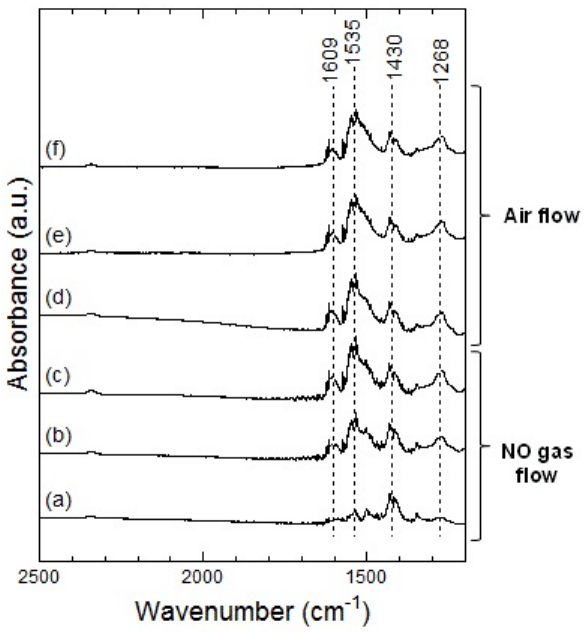
Figure 13. DRIFT spectra of Co 1 ppm of NO in air for ( a ) 2 min, ( b ) 20 min, and ( c ) 50 min. After NO exposure,